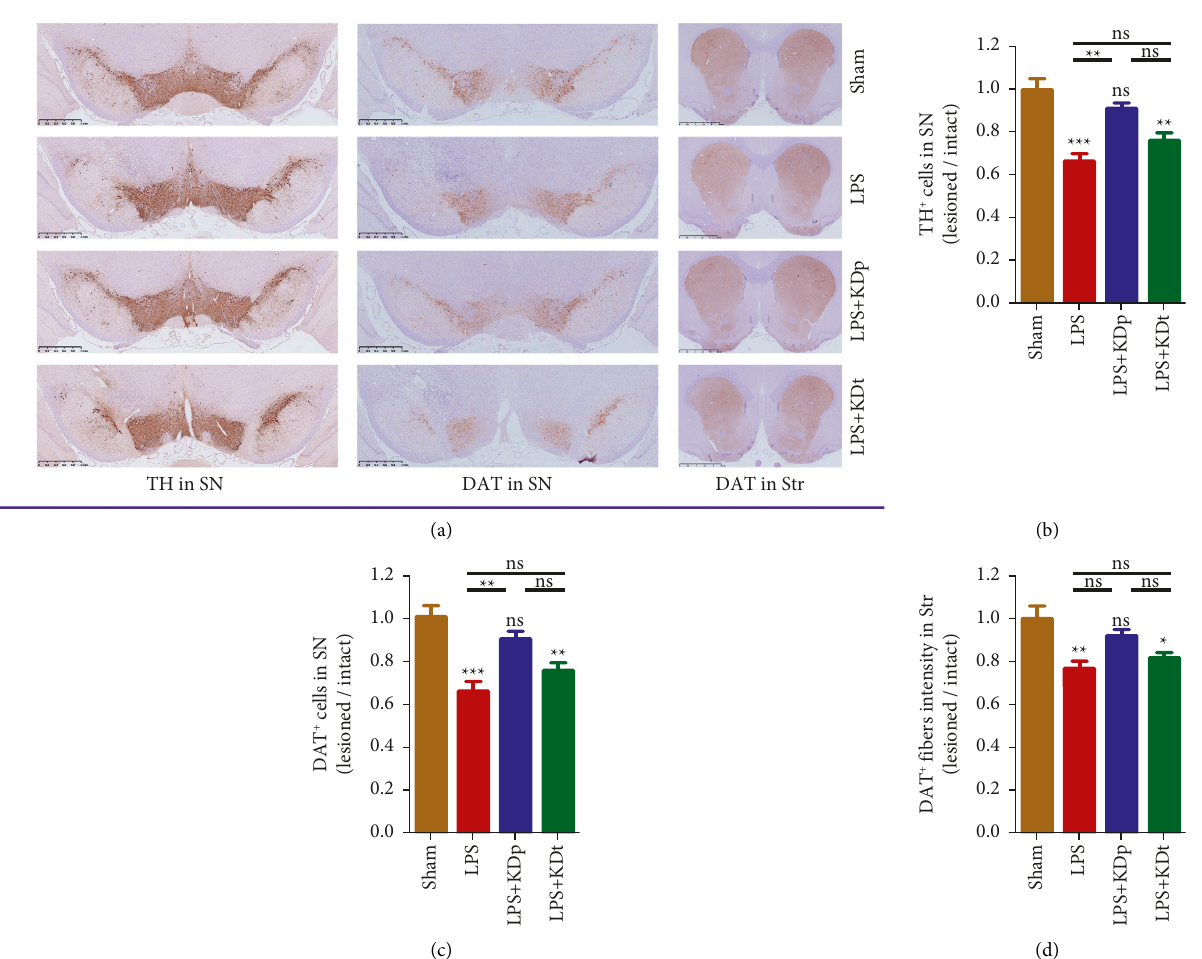
Figure 4: Deficient dopaminergic system in SN and Str. TH + (a), (b) and DAT + (a), (c) nerve cells in SN and DAT + fiber intensity in Str (a), (d) were compared among different groups. Data were presented as the mean ± SEM. ∗∗∗ P < 0 . 001; ∗∗ P < 0 . 01; ∗ P < 0 . 05; LPS, lipo- polysaccharide; KDp, preventive intervention with KD prior to the PD onset; KDt, therapeutic intervention with KD after the